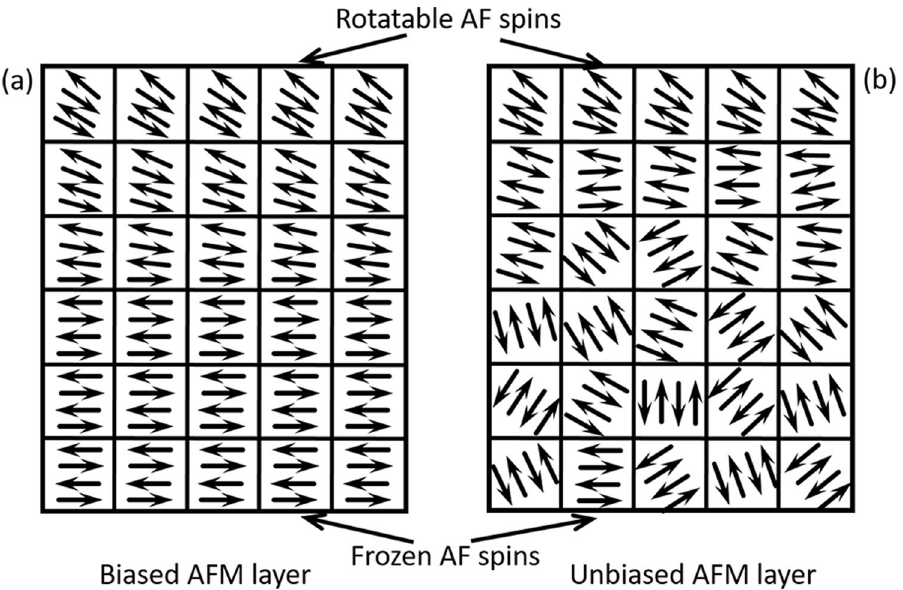
Figure 3. Schematic shows of the spin configurations of AFM sublayer in biased and unbiased bilayer. ( a ) AFM spins in biased AFM/FM bilayer and ( b ) AFM spins in unbiased AFM/FM bilayer. The arrows encased in the squares represent the directions of